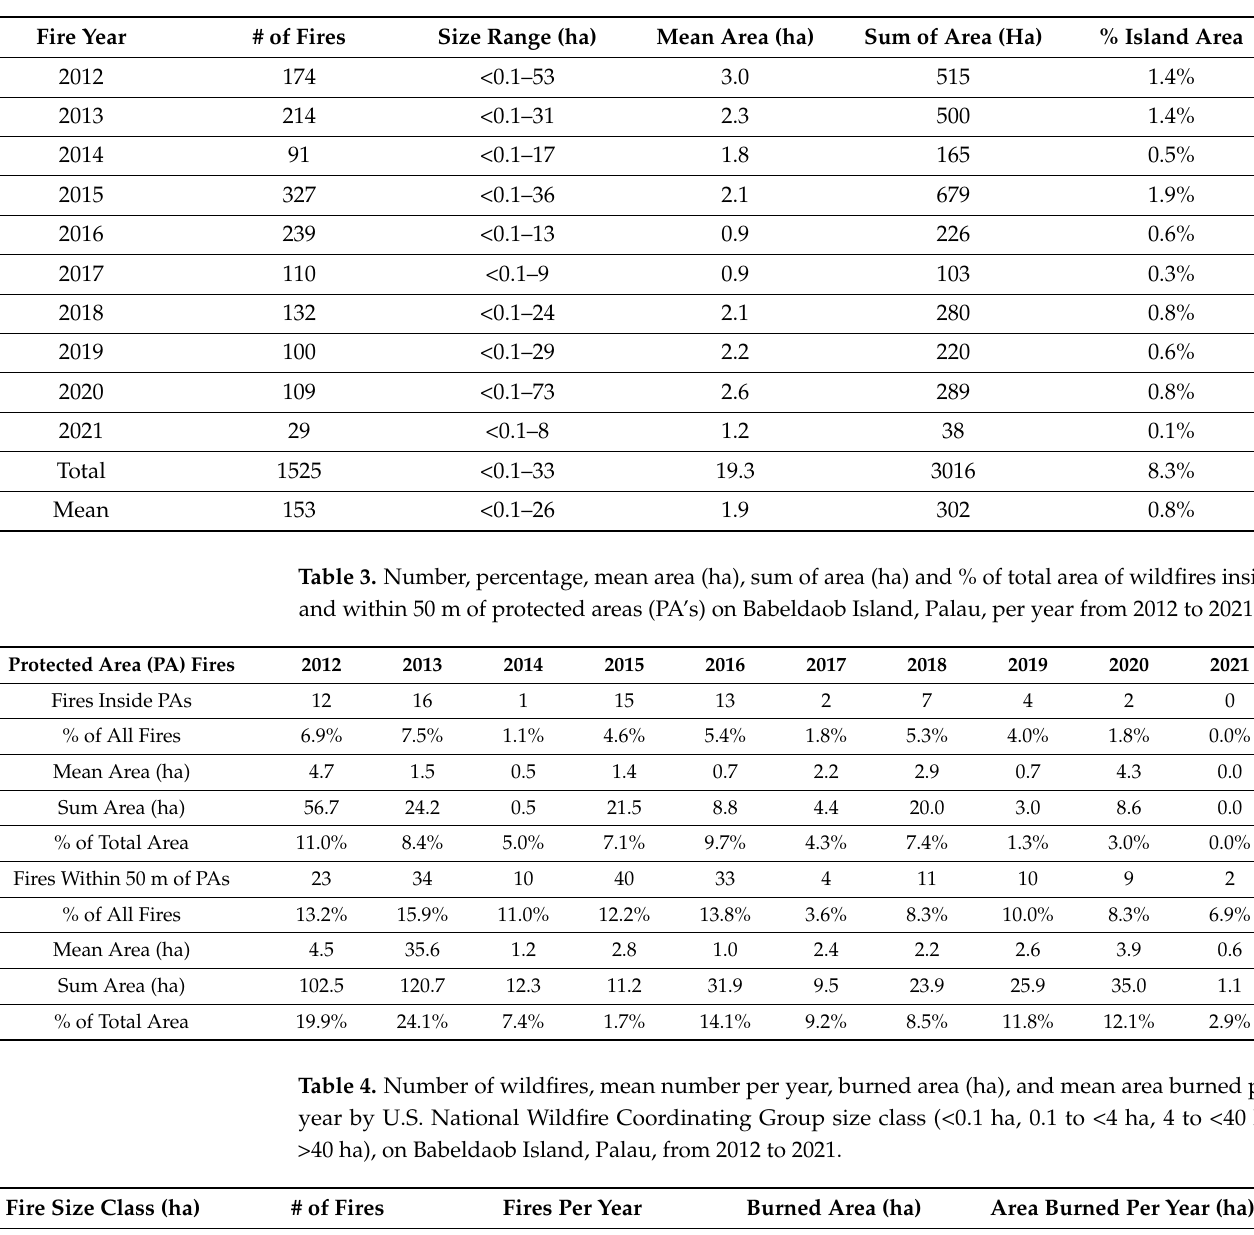
Table 2. Number of wildfires on Babeldaob Island, Palau, burned by year from 2012 to 2021, size range, mean area burned (ha), sum of area burned (ha) and % of total island area burned.